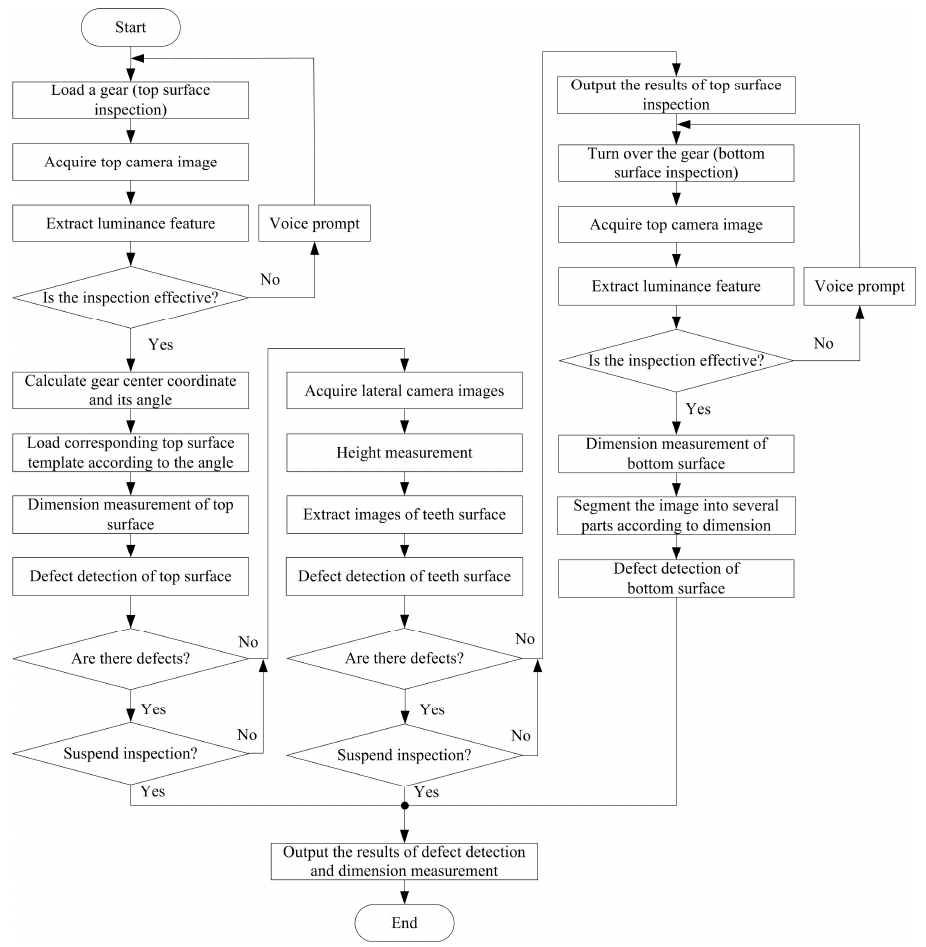
Figure 7. Software flowchart of bevel gear inspection system.